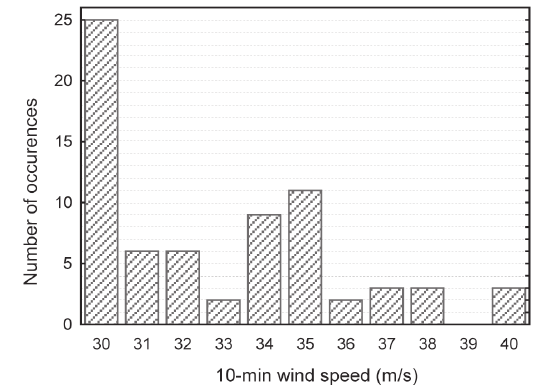
Fig. 2. Absolute frequencies of wind speeds recorded in